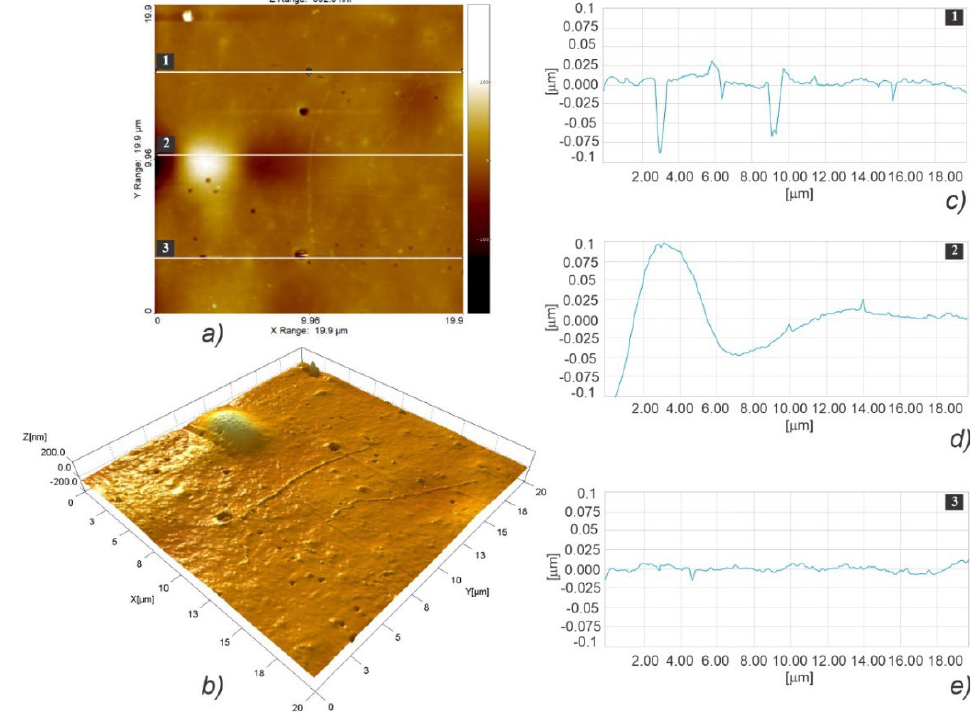
Figure 11. AFM topographic images obtained for the LLC scaffold over a 20 × 20 µ m area ( a , b ), and the corresponding profiles taken at locations marked with 1 ( c ), 2 ( d ), and 3 ( e ).